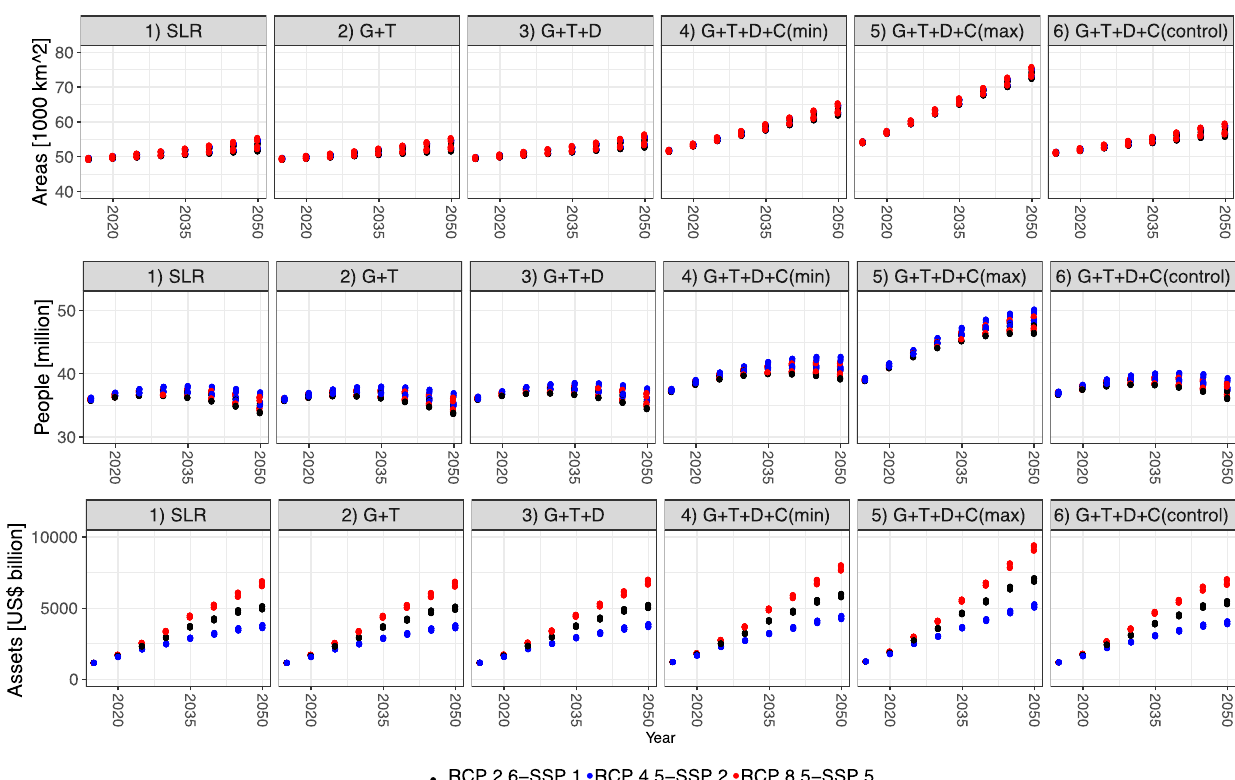
Fig. 3 | Potential fl oodplain extent, population and assets to a 100-year extreme coastal fl ood event under RCP-SSPscenariosbetween 2015and 2050. RSLR assumptions as indicated: (1) climate-induced SLR only; (2) climate-induced SLR, GIA and tectonics; (3) climate-induced SLR, GIA, tectonics and delta